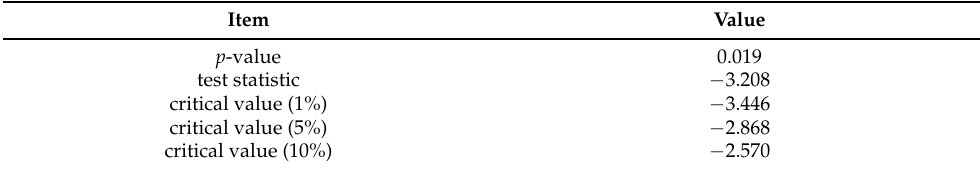
Table 4. Augmented Dickey-Fuller test of seasonally differenced SICs in sub-region No.